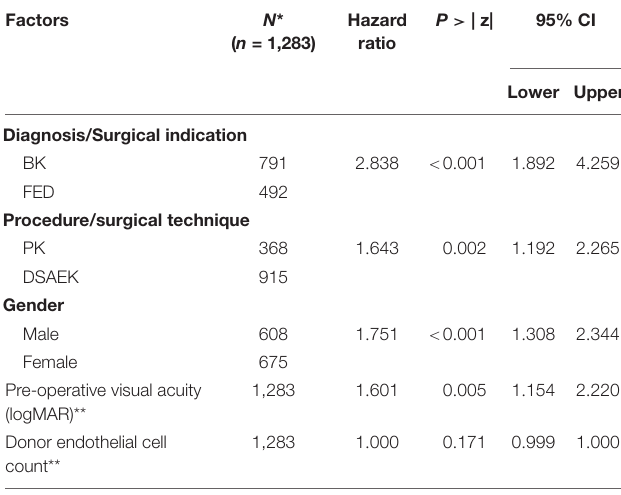
TABLE 2 | Hazard ratios for factors associated with 10-year graft failure using random survival forest to determine optimal multivariate regression model. Factors